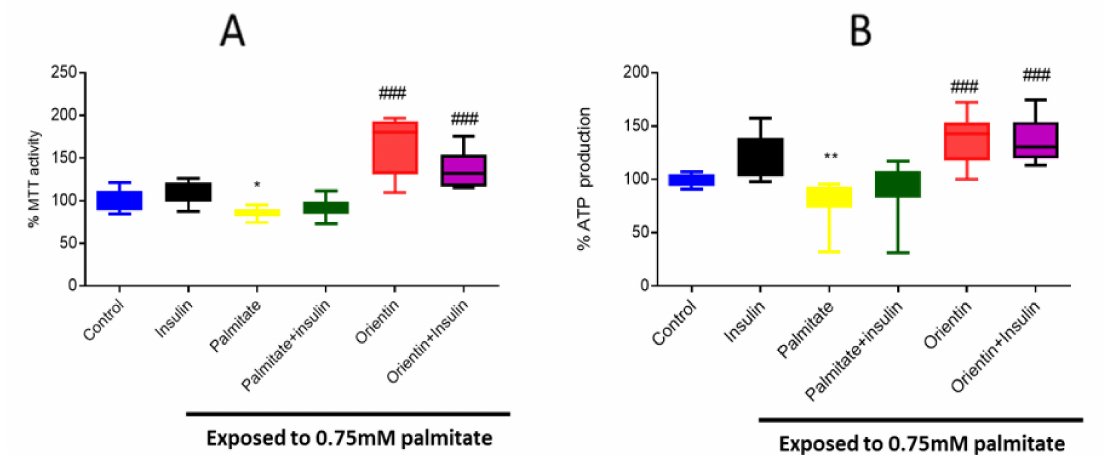
Figure 1. Effect of orientin on metabolic activity, measured by MTT activity ( A ) and ATP production ( B ) in C3A liver cells exposed to high (0.75 mM) palmitate concentration. Briefly, insulin-resistance was induced with 0.75 mM of palmitate for 16 h in C3A liver cells, followed by treatment with or without 10 µ M of orientin for 3 h and 1 µ M of insulin, which was added in the last 15 mins. Thereafter, cell metabolic activity was estimated utilizing MTT and ATP assays. Results are expressed as mean ± SD of 3 independent experiments. The bars depict statistical differences at * p < 0.05, ** p < 0.01, versus the experimental control set at 100% and ### p < 0.001 versus palmitate control.